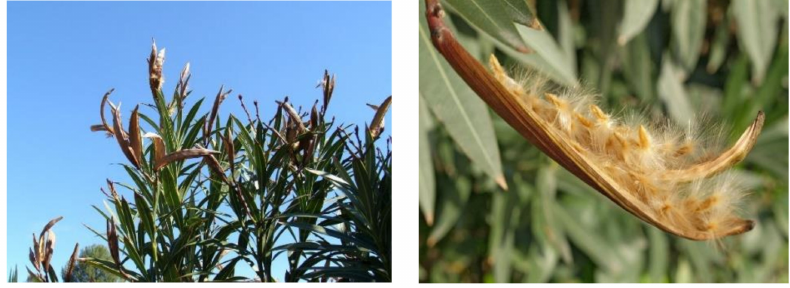
Figure 1. Photographs showing collection of Nerium oleander fruit as agricultural